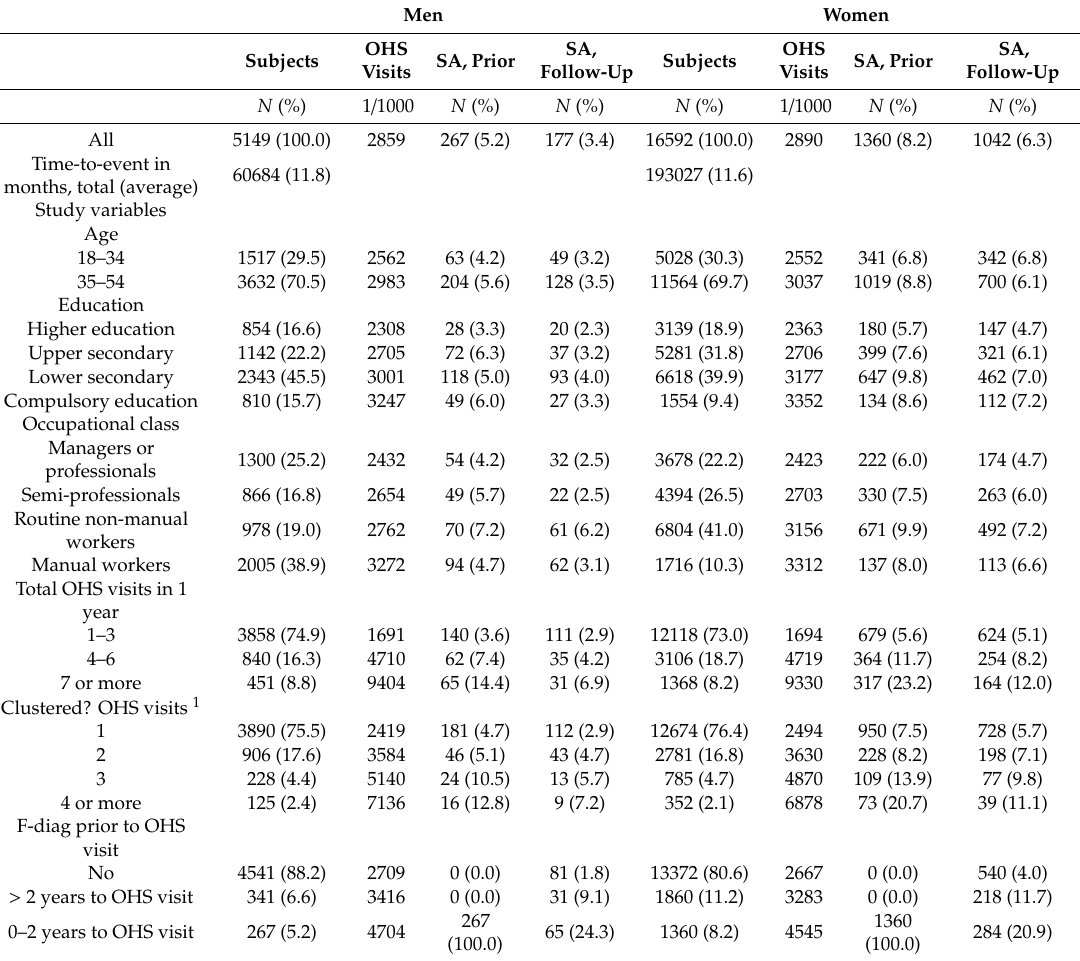
Table A1. Distributions of study variables, the mean of OHS visits in the year before the OHS visit and SA before and after OHS visit among the employees of the City of Helsinki, by